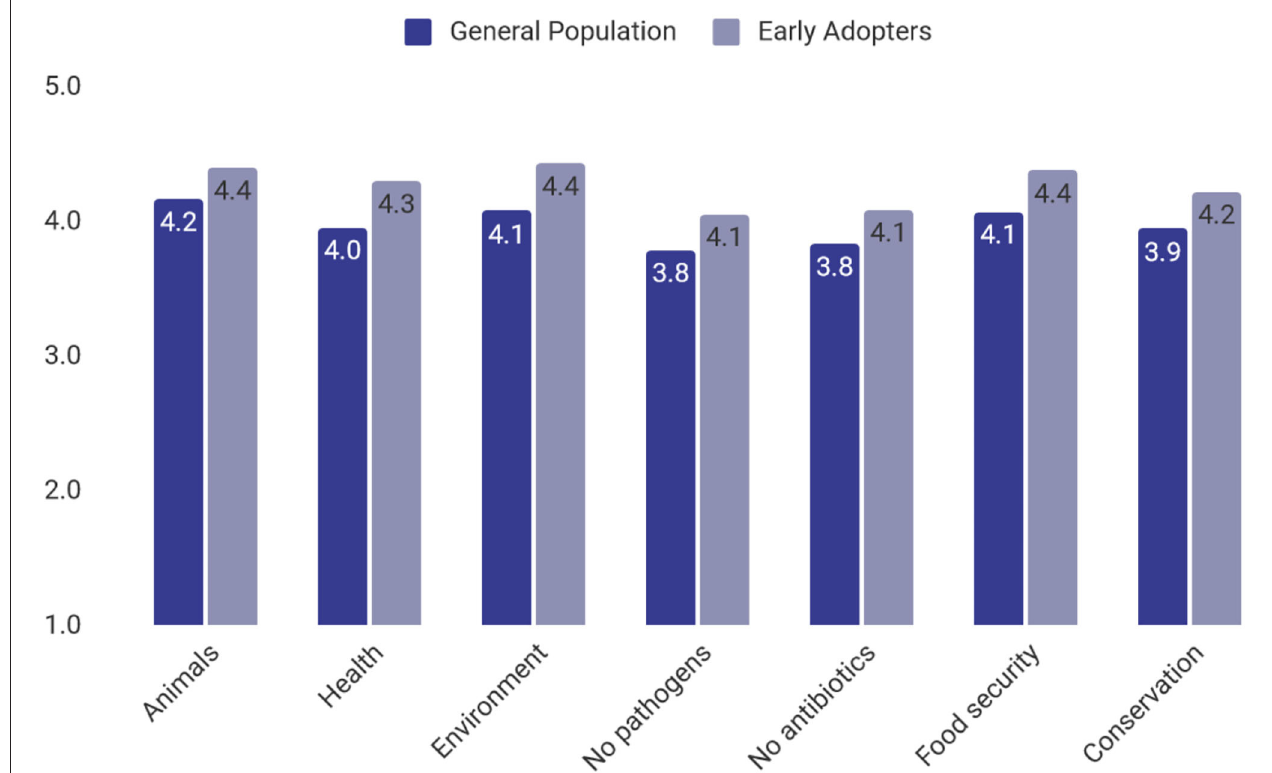
FIGURE 9 | Mean importance of motivations for cultivated meat in the general population and among early adopters.